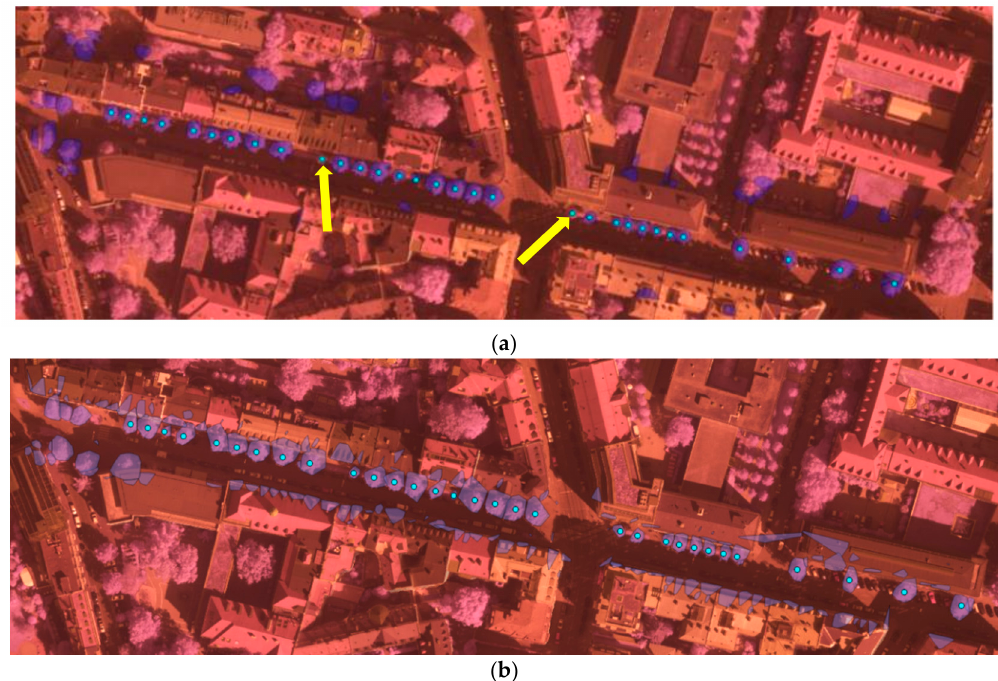
Figure 6. Single tree detection results of ( a ) Liebig ALS data; ( b ) Liebig MLS data.